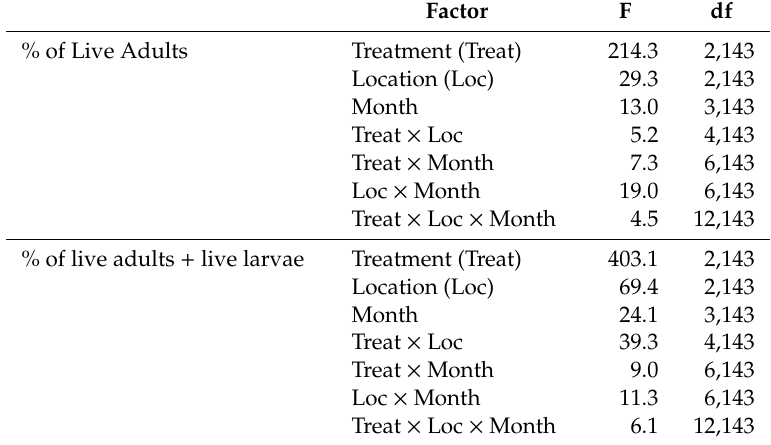
Table 3. Overall ANOVA (Proc Mixed, Statistical Analysis System, Version 9.4), for percentage of live adults 30 days after larvae were placed on the arenas, and percentage of live adults plus live larvae, for main e ff ects treatment (untreated controls and the two deltamethrin rates), location where arenas were held (outside, shed, or lab), and month post-treatment (0, 1, 2, or 3). All main e ff ects and interactions significant at p < 0.001.